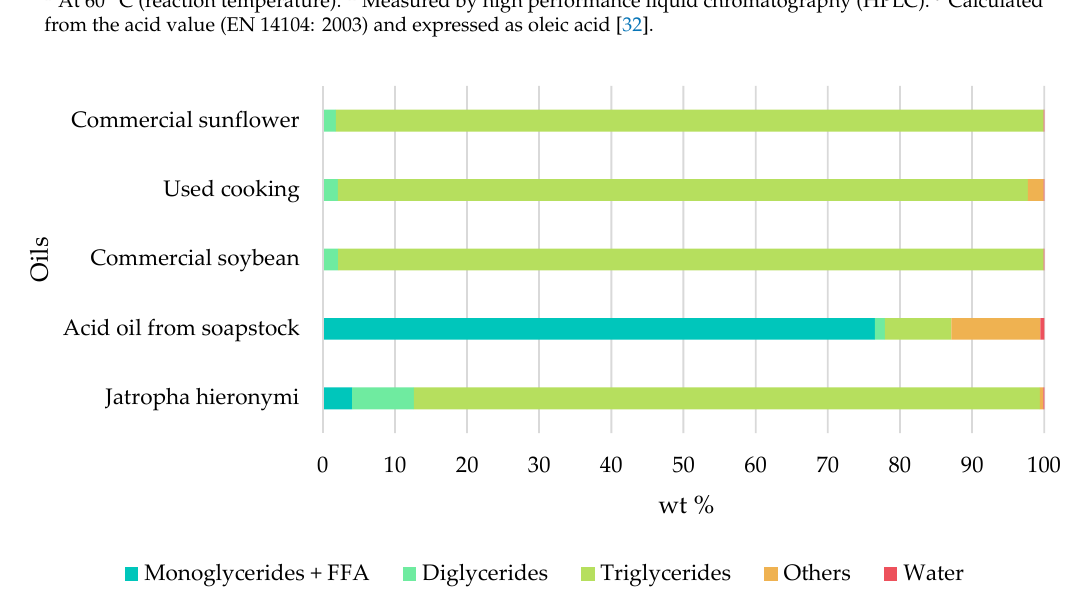
Figure 1. Composition of the evaluated feedstocks (by weight percentage) determined by HPLC.